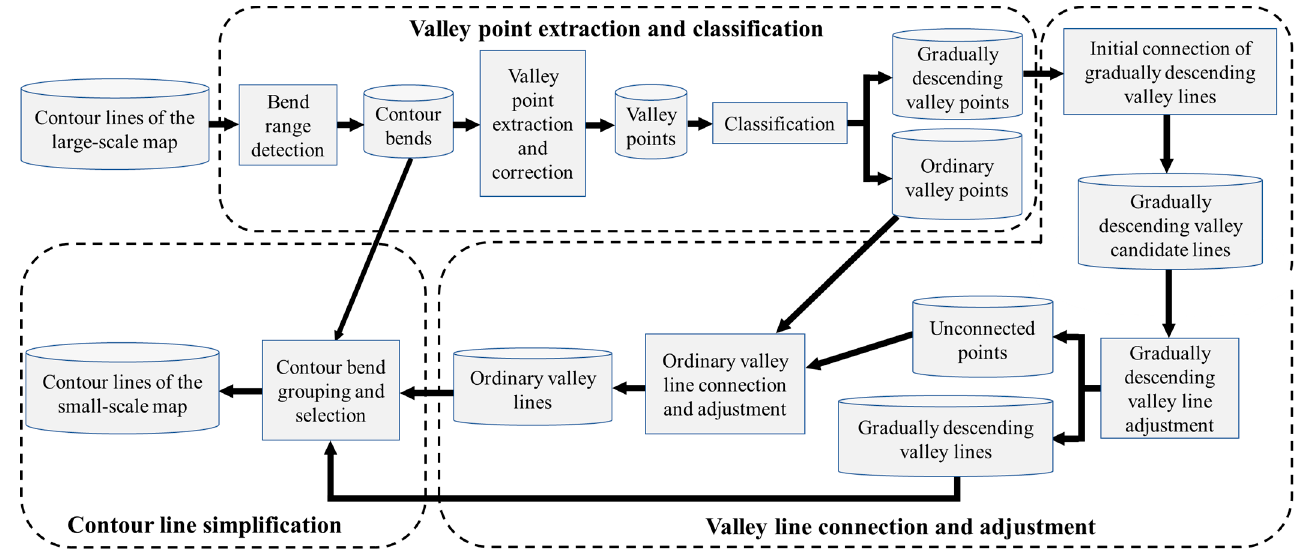
Figure 3. Framework of the proposed method.